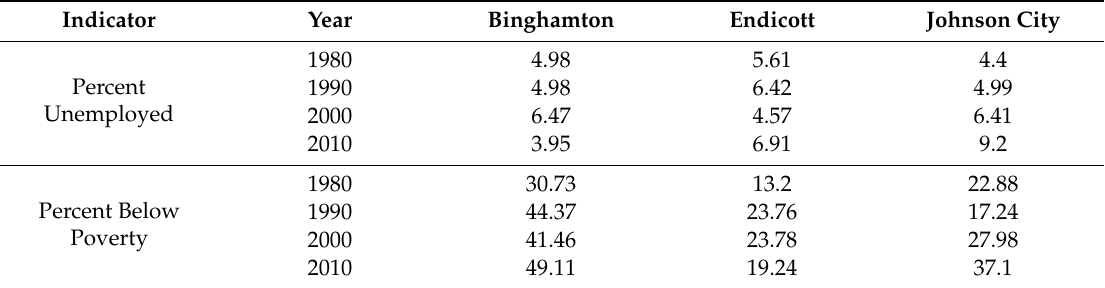
Table 1. Negative Trends for Indicators in three cities in the Greater Binghamton Area,